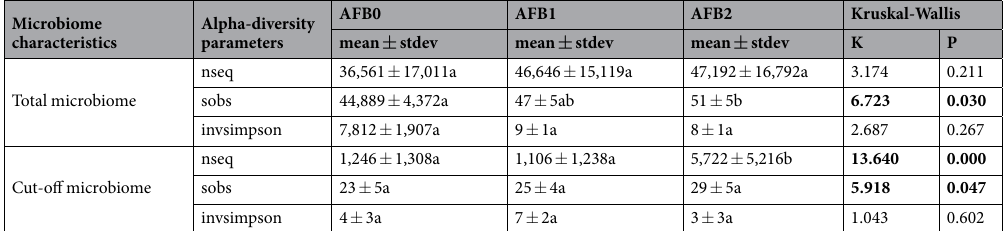
Table 2. Comparison of alpha-diversity parameters in the honeybee microbiome for both the total microbiome and the microbiome formed by environmental/pathogenic bacteria (cut-off microbiome). Samples from AFB apiaries with (AFB2) and without (AFB1) clinical symptoms and control (AFB0) samples outside the AFB zone were compared. Legend: nseq- total number of sequences; sobs – number of OTUs; invsimpson – inverse Simpson diversity index.